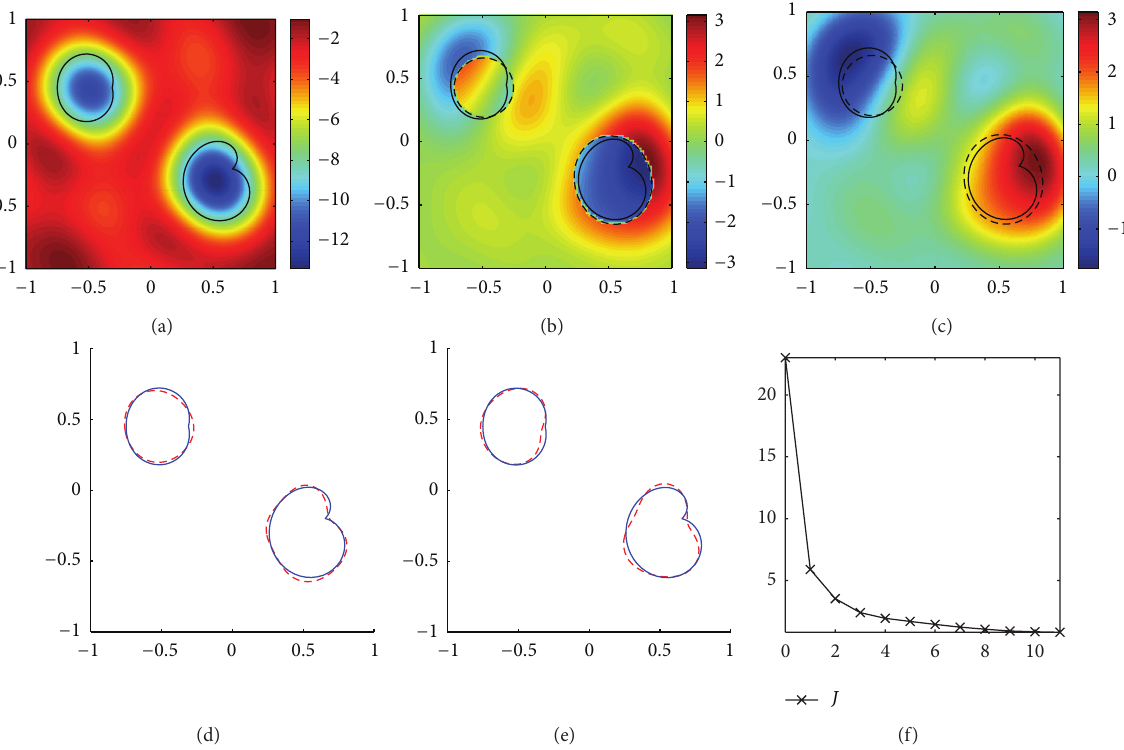
Figure 6: Comparison of the alternative definitions of the topological derivative inside an object and of the monotone and nonmonotone methods. (a) Topological derivative when Ω = 0 . (b) Initial guess Ω 0 (dashed lines) superimposed to the topological derivative for Ω = Ω 0 using the extended definition (21) inside Ω . (c) Counterpart of (b) using the extended definition (26). (d) Final reconstruction at the 11th iteration using the non-monotone method (dashed red line). (e) Final reconstruction at the 9th iteration using the monotone method (dashed red line). (f) Evolution of the cost functional applying the non-monotone